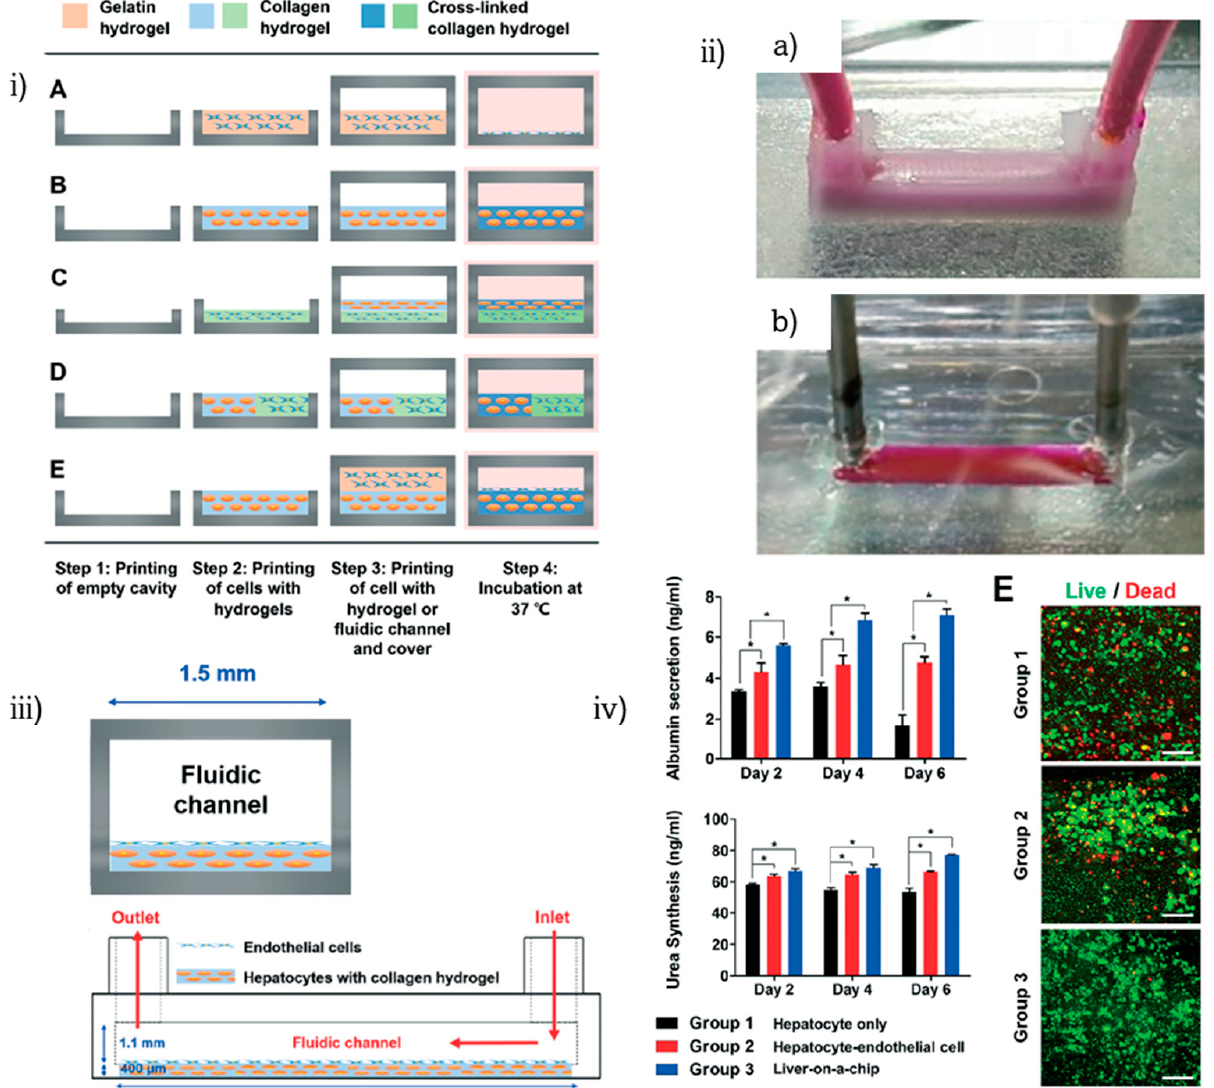
Figure 10. Liver-on-chip in one-step fabrication: ( i ) 3D bioprinting procedure for different organs-on-chips, ( ii ) microfluidic chip from (a) PCL and (b) PDMS, ( iii ) side view and vertical section